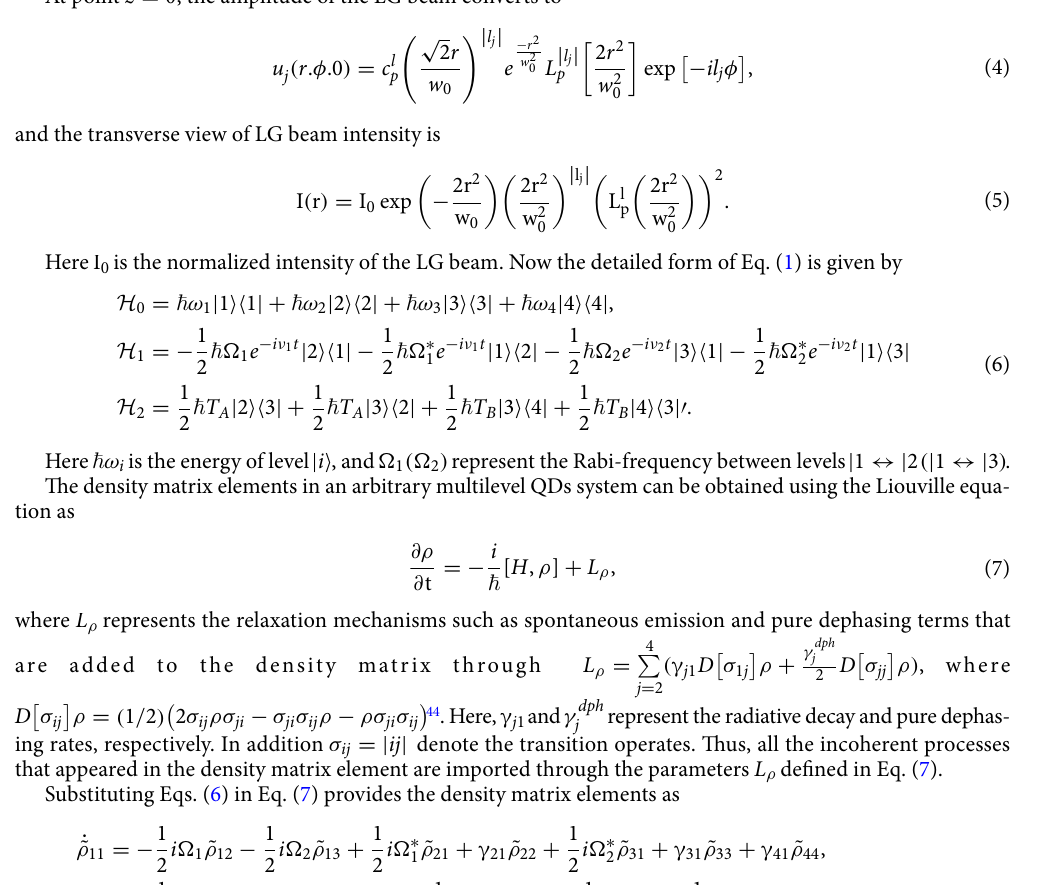
0 , the amplitude of the LG beam converts to At point z =